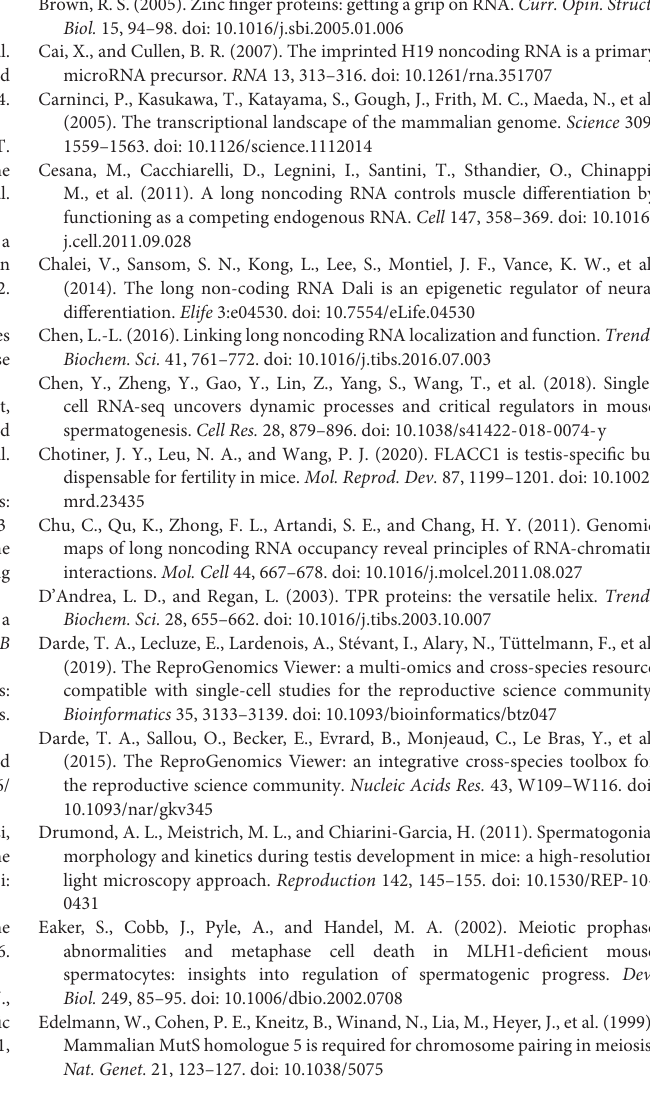
analysis (based on GO terms and KEGG pathway) of all P16-differentially expressed genes (sheet 1) or only up-regulated DEGs (sheet 2) or down-regulated DEGs (sheet 3) in Topaz1 − / − testes. analysis (based on GO terms and KEGG pathway) of P18-differentially expressed genes (sheet 1) or only up-regulated DEGs (sheet 2) or down-regulated DEGs (sheet 3) in Topaz1 − / − testes. Annotation clusters based on the InterPro database of P18-down-regulated DEGs are mentioned in sheet 4. Supplementary Table 6 | List of DEGs in 4930463O16Rik − / − testes compared to WT. List of deregulated genes in 4930463O16Rik KO testes at P16 (sheet 1) and P18 (sheet 2) (adjusted p-value < 0.05 and absolute Log2FC > 1). Supplementary Table 7 | Functional annotation of P18 DEGs (RNA-seq 4930463O16Rik − / − vs. WT testes). DAVID functional Annotation Clustering (DAVID 6.8) analysis of P18-differentially expressed genes (sheet 1) or only up-regulated (sheet 2) or down-regulated DEGs (sheet 3) in 4930463O16Rik − / −